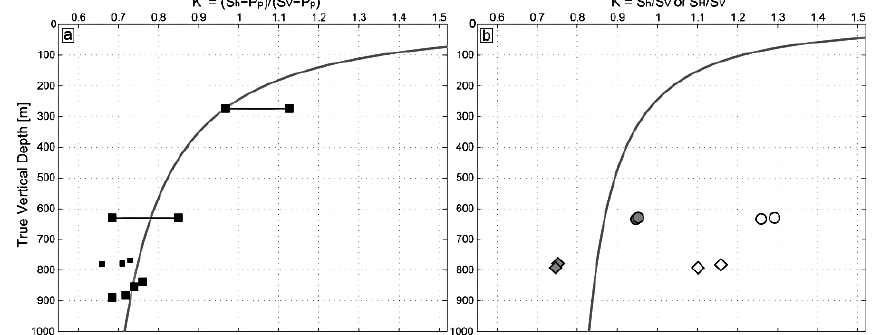
Figure 5. Depth-dependent stress ratio in Opalinus Clay in northern Switzerland. (a) Effective stress ratio K (cid:48) . Line shows calculated K (cid:48) ratio for Opalinus Clay according to Eq. (2) and underlying database (large black squares) from the underground lab Mont Terri (present depth approximately 280m, OCR ≈ 4), and the wells in Benken ( ∼ 630m, OCR ≈ 2) and Schlattingen ( ∼ 900m, OCR ≈ 1.7) assuming φ (cid:48) = 25 ◦ . The small black squares represent data from Upper Dogger samples from Schlattingen with comparable clay mineral content as the Opalinus Clay. (b) Line shows calculated total stress ratio K (Eq. 4), which is used to calibrate the initial stress state in Opalinus Clay in the model. Symbols show hydraulic fracturing data and represent the in situ stress state including tectonic loading (diamonds, Schlattingen (Klee, 2012); circles, Benken (Nagra, 1999); filled symbols, S h /S V ; open symbols, S H /S V ) .